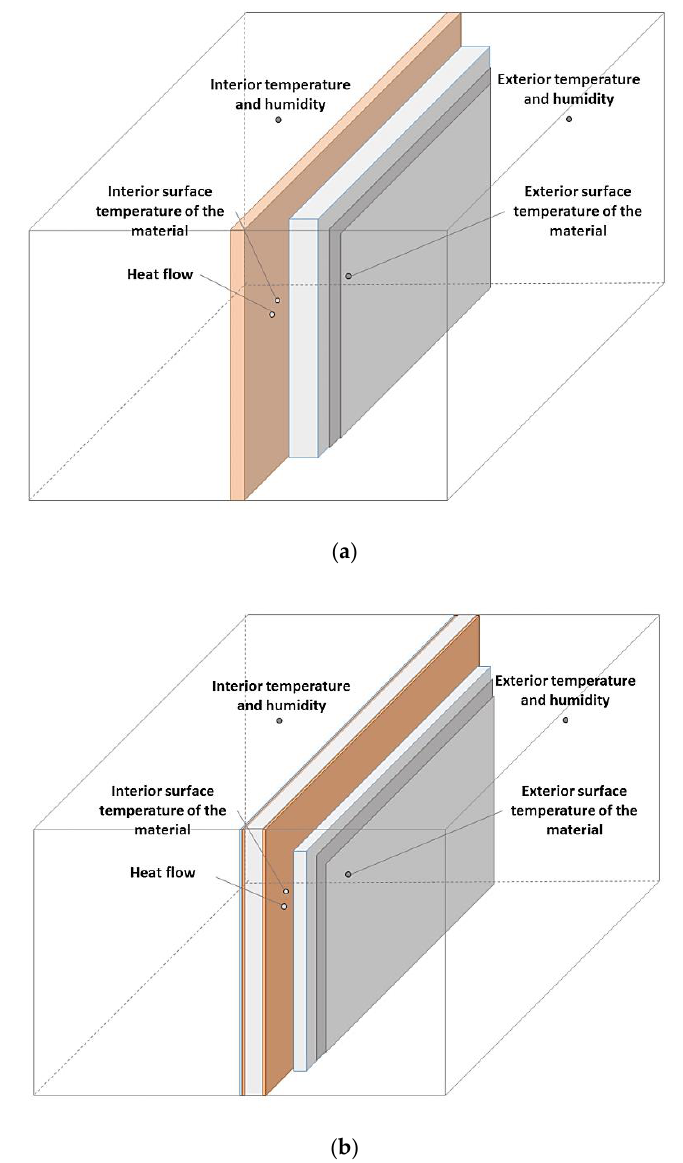
Figure 1. Test samples under laboratory conditions and location of measuring points. Note: ( a ) Prefab cross laminated timber structure, locations of measuring points—variant A; ( b ) prefab structural insulated panels, locations of measuring points—variant B. (Note: the compositions of the layers of individual structures are given in Tables 1 and 2).